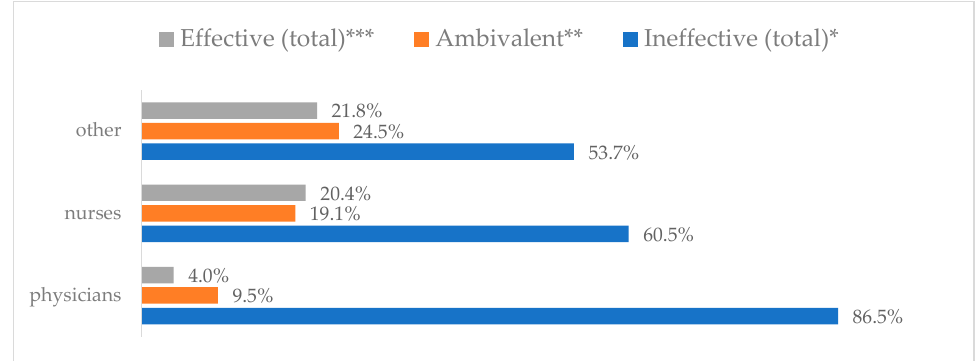
Figure 25. Eating garlic to prevent influenza virus infection by seniority ( N = 905). *Sum of re- sponses: completely ineffective, ineffective, rather ineffective; **Response: neither ineffective nor effective; ***Sum of responses: rather effective, effective, completely effective. 3.8. Method 6: Taking Preparations with Inosine The use of inosine preparations to prevent influenza virus infection was rated differ- ently by gender, age, and hospital type (Table 8). Men considered preparations with ino- sine as ineffective more often than women (33.0%, N = 266 for women vs. 43.4%, N = 62 for men) (Figure 26). Taking preparations with inosine was considered completely inef- fective in preventing influenza illness by an average of four in ten people aged 18–40 and over 60, and one in four people aged 41–60 (40.3%, N = 89 for 18–30; 42.2%, N = 87 for 31–